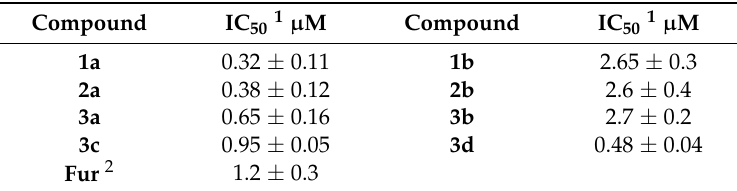
Table 1. Tdp1 Inhibitory activity of compounds 1a , b , 2a , b and 3a – d .